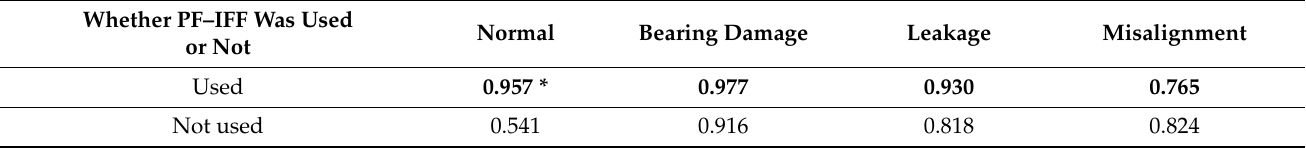
Table 7. Comparison